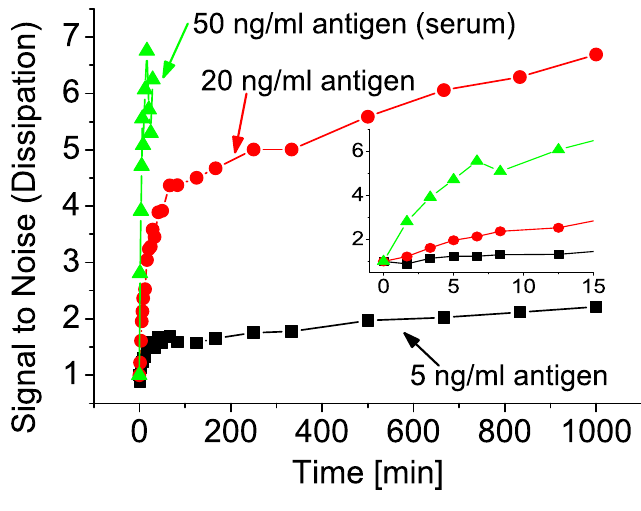
Figure 4. The signal-to-noise ratio of the vesicle adsorption is shown as a function of the incubation time. The inset shows a zoom in of the first 15 minutes. Note that polymeric vesicles were used for the detection from serum because of their enhanced